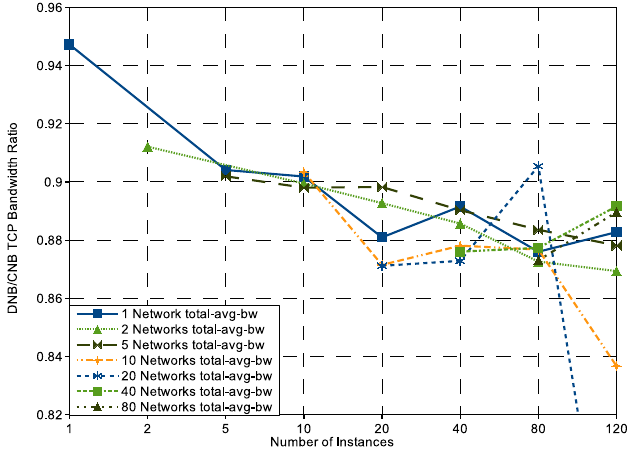
Fig. 8: Bidirectional TCP bandwidth comparison